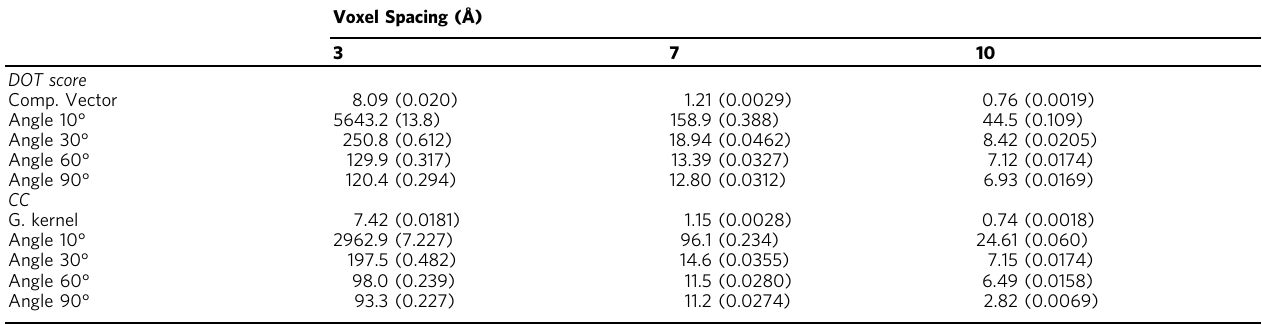
Table 4 CPU hours for combinations of voxel and angle spacing settings. Voxel Spacing (Å) 3 10 DOT